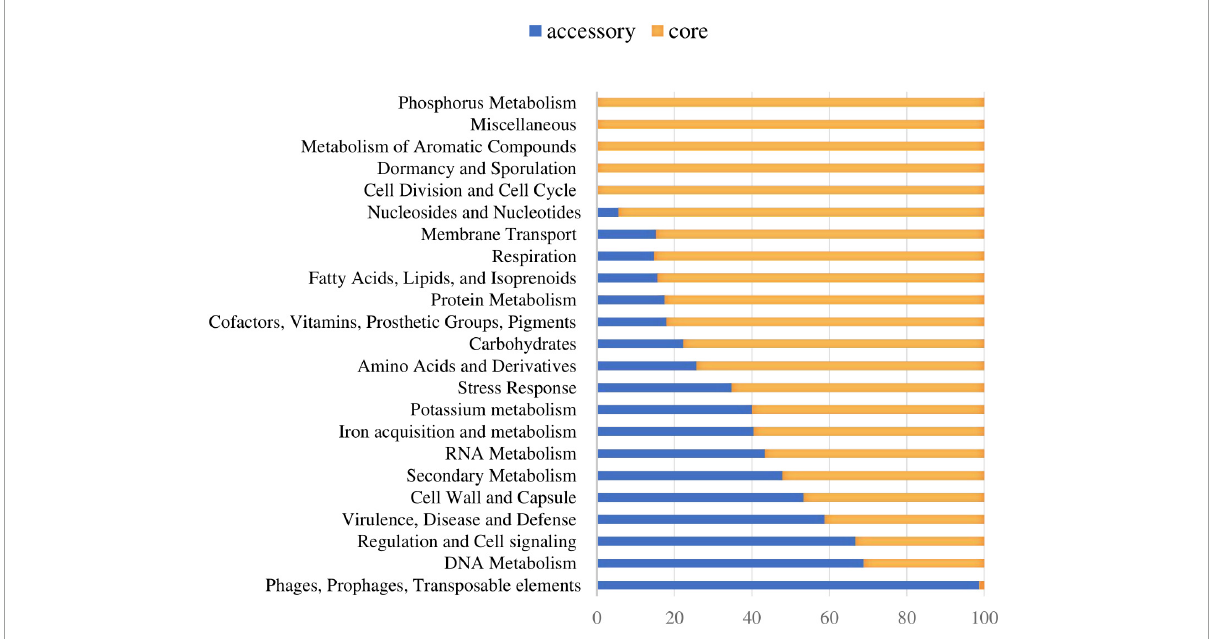
FIGURE1 Distribution of the core and accessory genes in different functional categories investigated in S. dysgalactiae